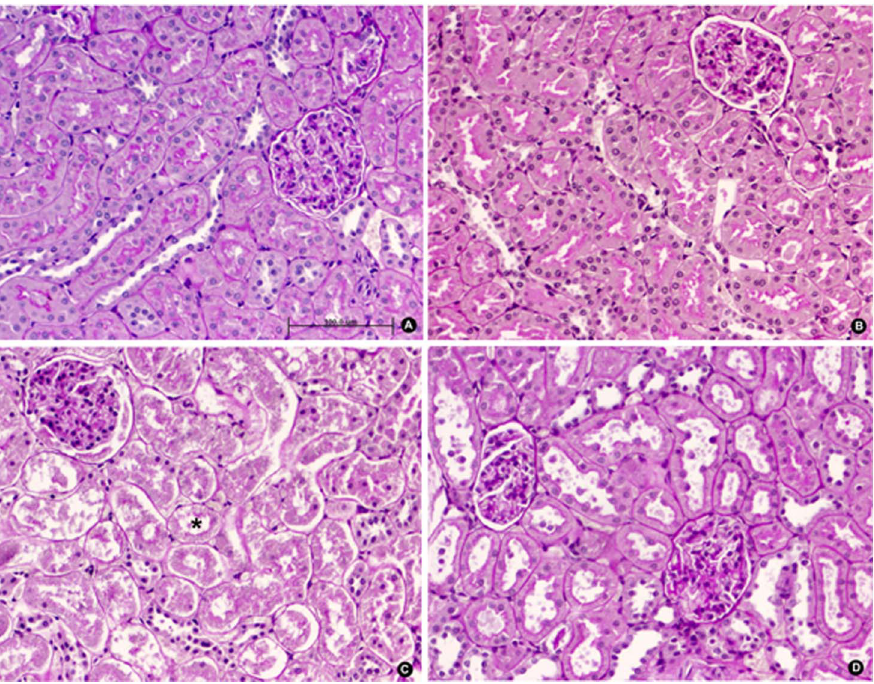
Figure 7. Representative microphotograph of morphological changes in renal parenchyma of male Wistar rats after 48 h of ischemia-reperfusion. Absence of glomerular or tubular injury in kidney sections of rats in SO-P (A) and SO-T3 (B) groups. Rats exposed to bilateral renal ischemia-reperfusion pre-treated with placebo, IR-P (C), show intense acute tubular necrosis (asterisk) with severe detachment of epithelial cells from the basement membrane, loss of brush border, and intratubular casts. The IR-T3 group (D) shows mild tubular necrosis and moderate sloughing of tubular cells (PAS, original magnification 6 20).